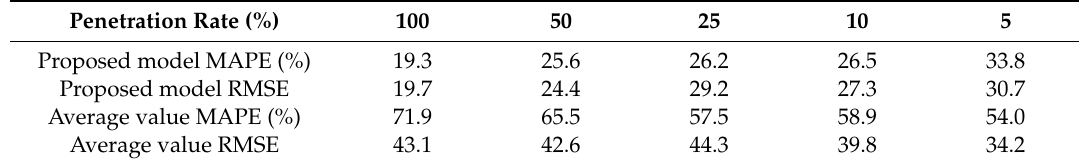
Table 2. Accuracy for the proposed model under different penetration rates.